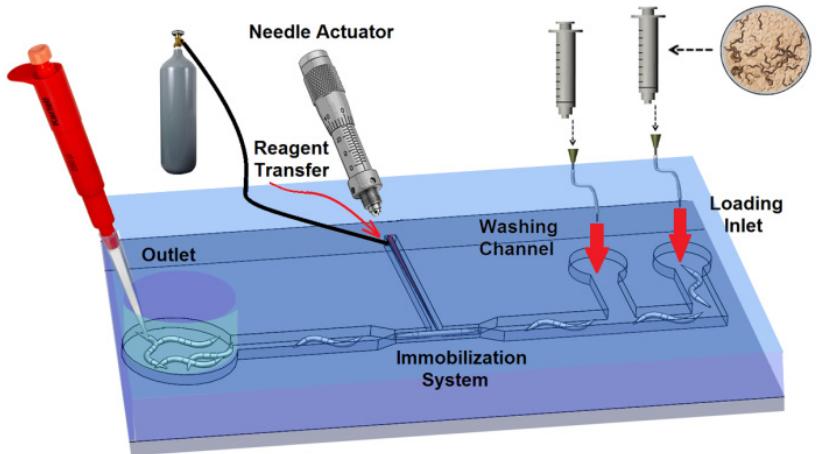
Figure 1. Schematic of the five parts of the microinjector including a loading channel, immobilization mechanism, needle actuation mechanism, reagent delivery system and unloading channel.